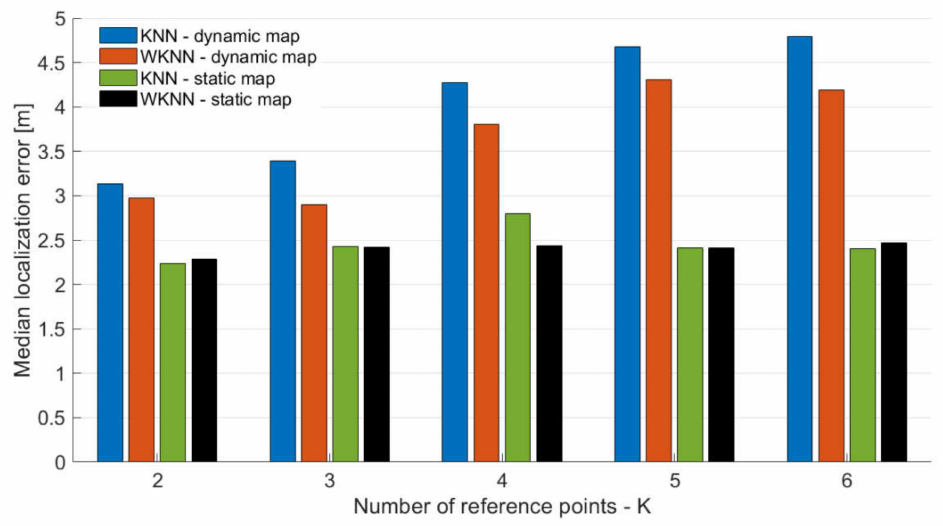
Figure 7. Impact of the number of reference points used for position